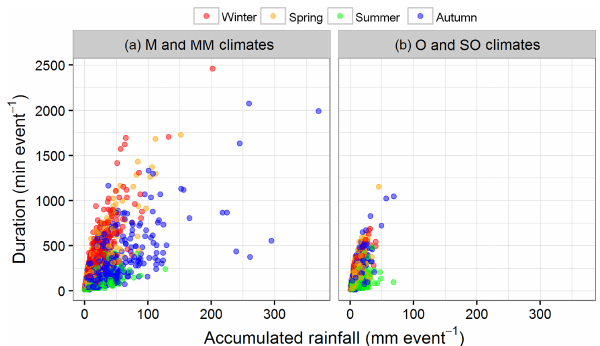
Figure 4. Rainfall duration vs. accumulated rainfall across sea- sons for each marked rainfall event at Mediterranean (M) and Mediterranean–mountain (MM) stations (a) and at oceanic (O) and semi-oceanic (SO) stations (b)